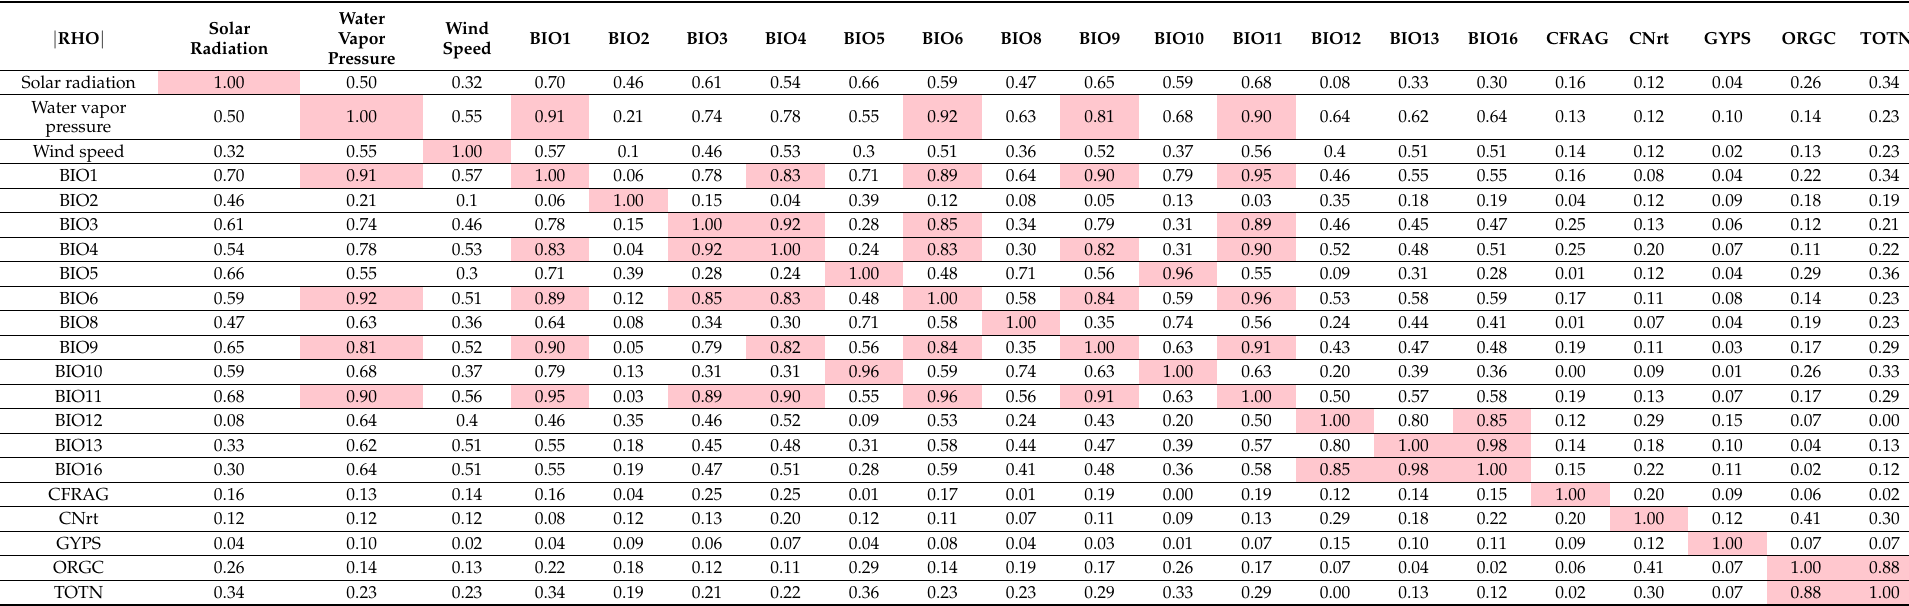
Table A4. The absolute values of the correlation coefficients of initially selected environmental